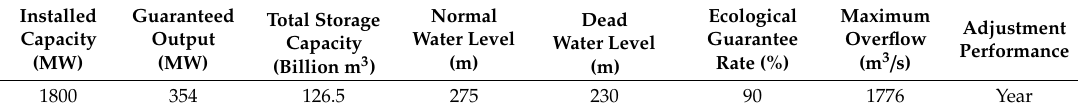
Table 1. Main parameters of Xiaolangdi.